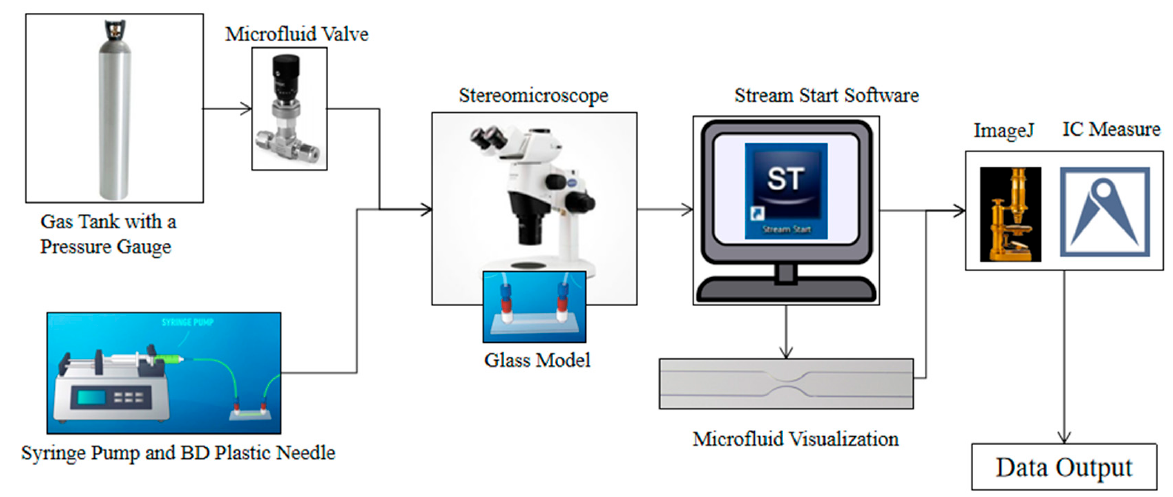
Figure 3. Equipment Set-Up.